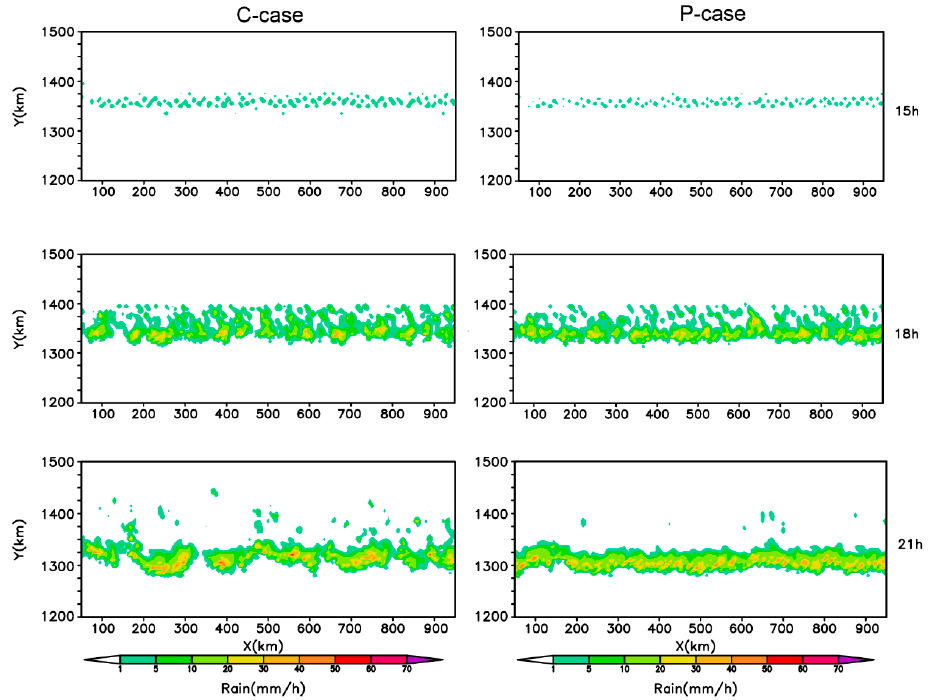
Figure 3. Evolution of precipitation distribution (t = 15, 18, 21 h) in the model domain (Only a 1000 km × 300 km of the domain is presented). The left panels represent C-case, and the right panels represent P-case.